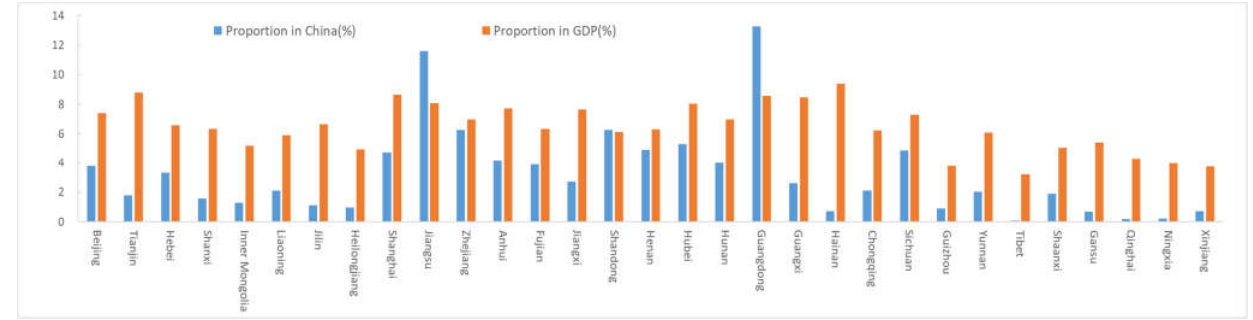
Figure 3. Comparative analysis of China’s real